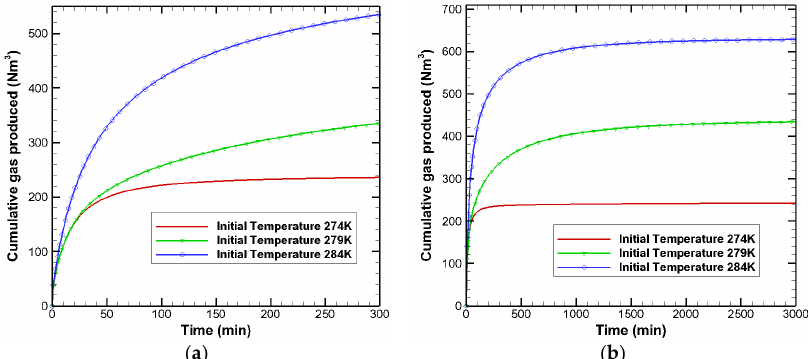
Figure 7. Comparisons of cumulative gas produced under well pressure of 3 MPa and different initial temperatures (274 K, 279 K, and 284 K) at different exploiting time ( a ) 300 min; ( b ) 3000 min.